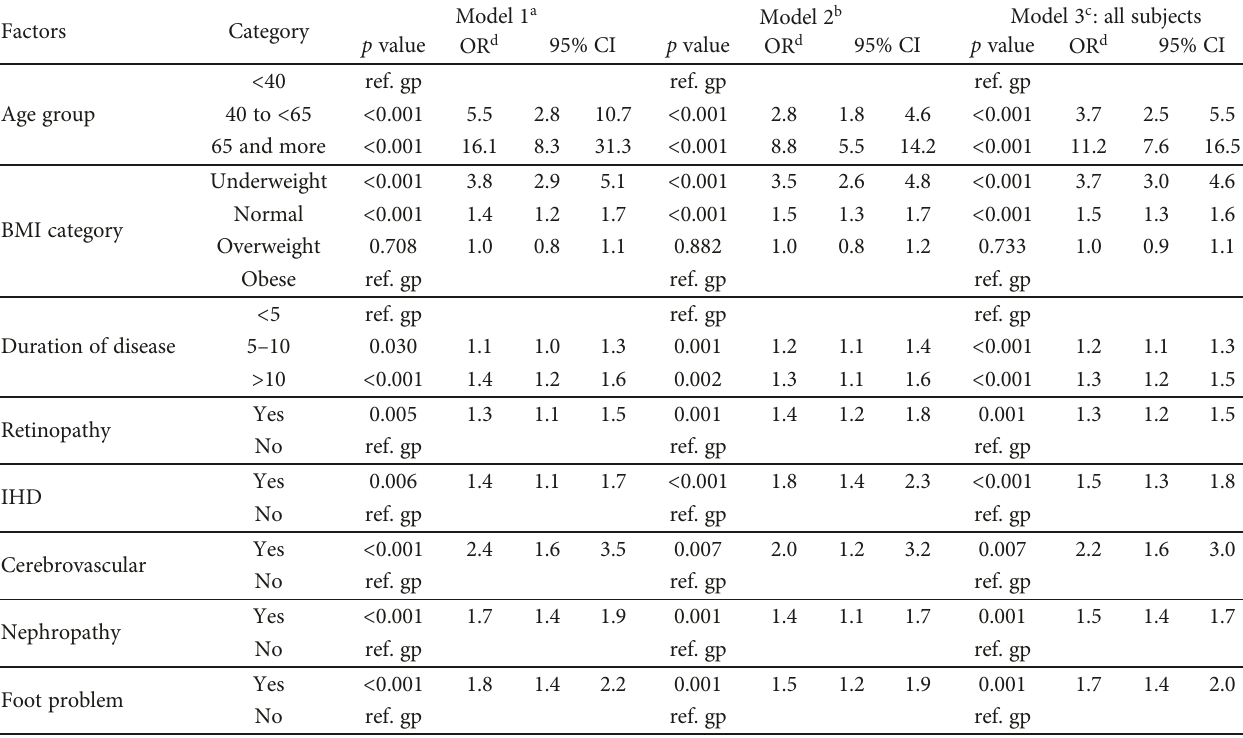
Table 3: Association of selected factors toward status of death within fi ve